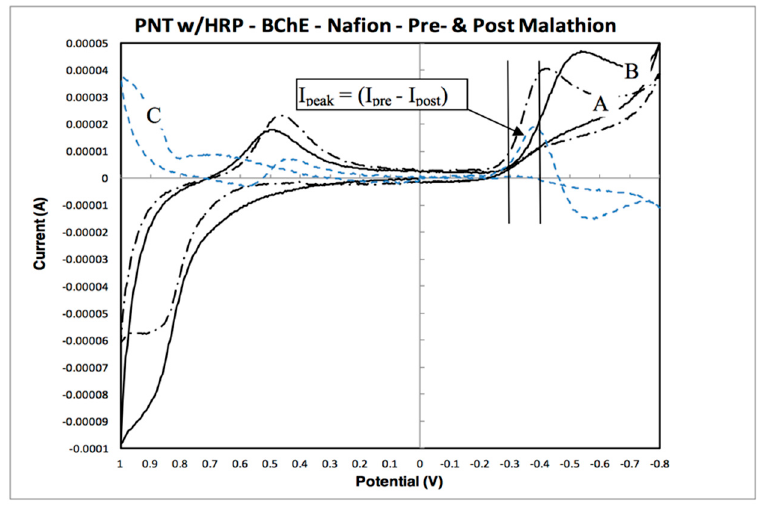
Figure 3. Representative CV data for peptide nanotubes (PNT) with horseradish peroxidase (HRP)/BChE/Nafion composition matrix: Line A is (I pre ), line B is (I post ), and line C is (I pre − I post ).